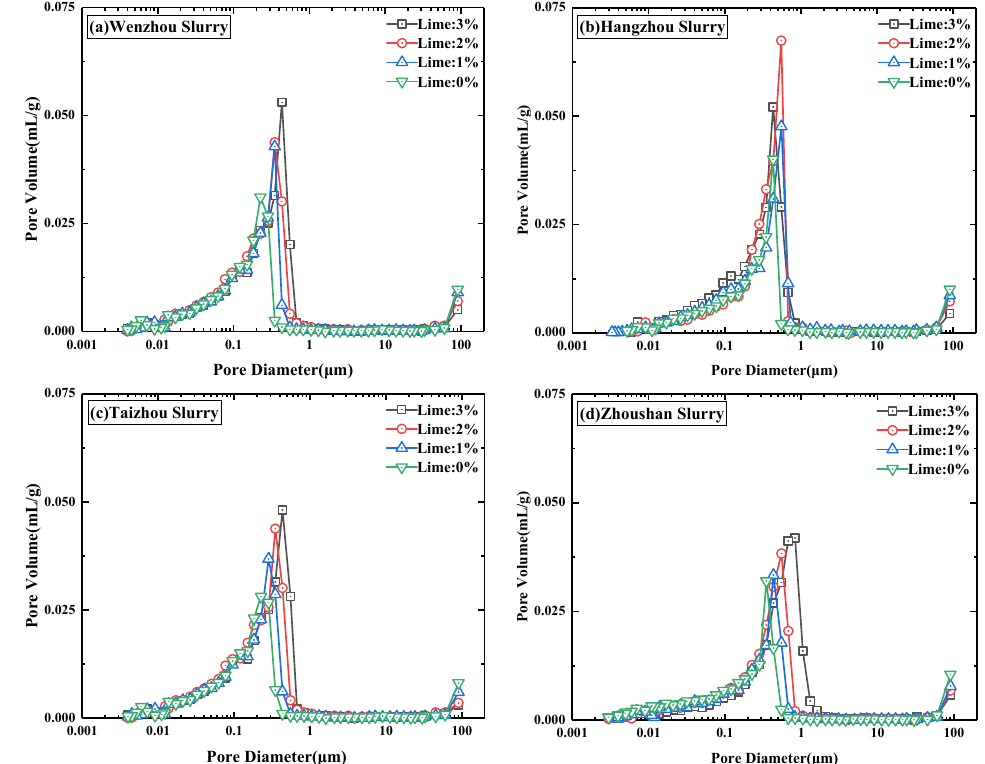
Figure 7. Pore volume distribution curves of stabilized slurry for each group with different lime dosages. ( a ) Wenzhou soil sample, ( b ) Hangzhou soil sample, ( c ) Taizhou soil sample, ( d ) Zhoushan soil